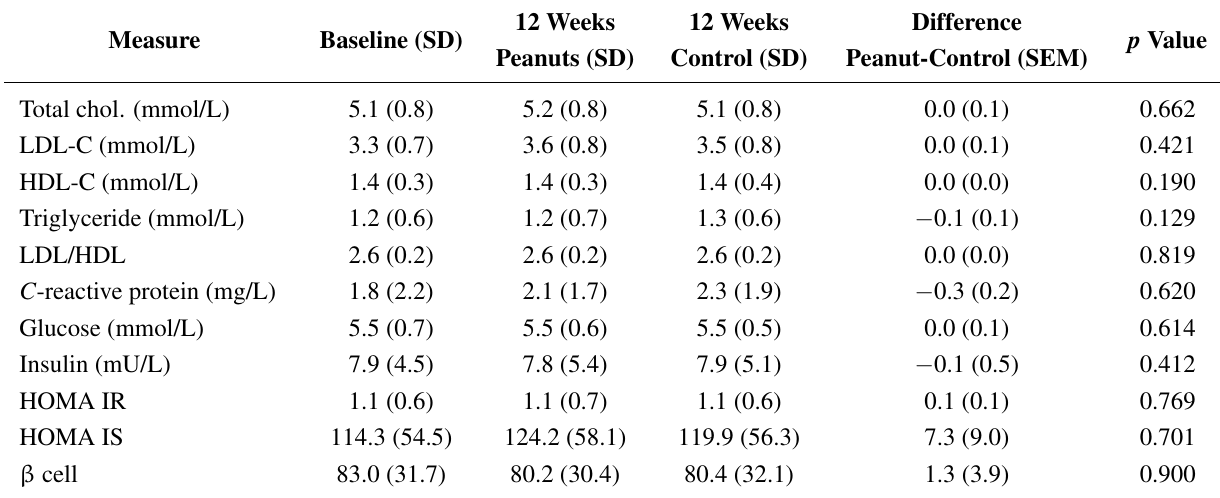
Table 4. Effect of 12 week high oleic peanut consumption and nut free diet on fasting blood lipids, inflammation ( C -reactive protein) and glucose